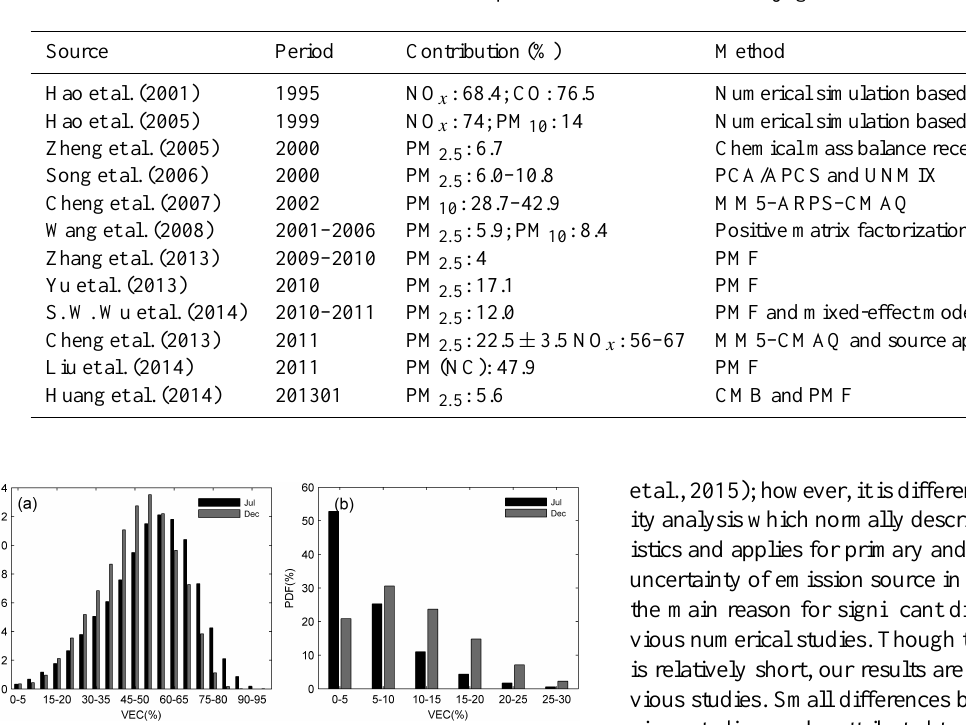
Figure 4. Annual mean emissions and the rate of vehicle emission in total emission for NO 2 (a, c) and PM 2 . 5 (b, d) respectively. Black lines represent the main traffic arteries in Beijing. Table 4. The contributions of traffic emission on ambient pollutant concentrations in Beijing.